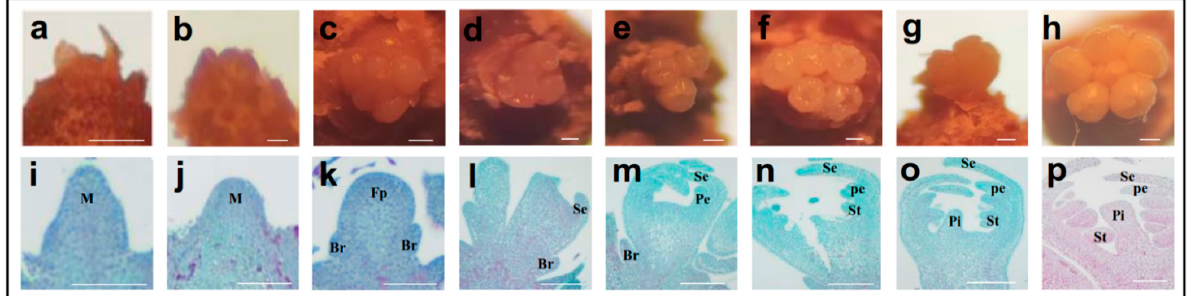
Figure 1. The anatomical and histological characterization in flower bud differentiation of P. pseu- docerasus ‘Manaohong’. ( a – h ): internal morphology of individual flower bud observed using the stereomicroscope. ( i – p ): histological changes in individual flower bud. ( a , i ): physiological differenti- ation stage, undifferentiated meristematic apex is cone shaped; ( b , j ): differentiation initiation stage, the growth center begins to expand, and it is dome shaped; ( c , k ): floral primordium differentiation stage, from 2 to 6 small protrusions appeared; ( d , l ): sepal primordium differentiation stage, the growth center is flat, the surrounding parts are protruding, the whole of it is like a cup; ( e , m ): petal primordium differentiation stage, a new round of protrusions is generated on the inner side of the elongated sepal primordia; ( f , n ): stamen primordium differentiation stage, multiple protrusions are generated inside the elongated petal primordia; ( g , o ): pistil primordium differentiation stage, a new protuberance on the flat central part of the floral primordium; ( h , p ): differentiation has Table 1. Flower bud differentiation stages of ‘Manaohong’ and their percentage (%) in the observed buds.